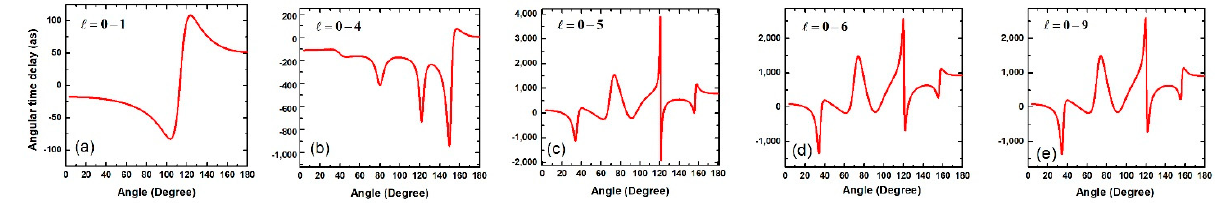
Figure 10. Angular time delay at the resonant energy 0.1811 a.u. plotted for different partial wave combinations ( a ) (cid:96) = 0–1, ( b ) (cid:96) = 0–4, ( c ) (cid:96) = 0–5, ( d ) (cid:96) = 0–6 and ( e ) (cid:96) =